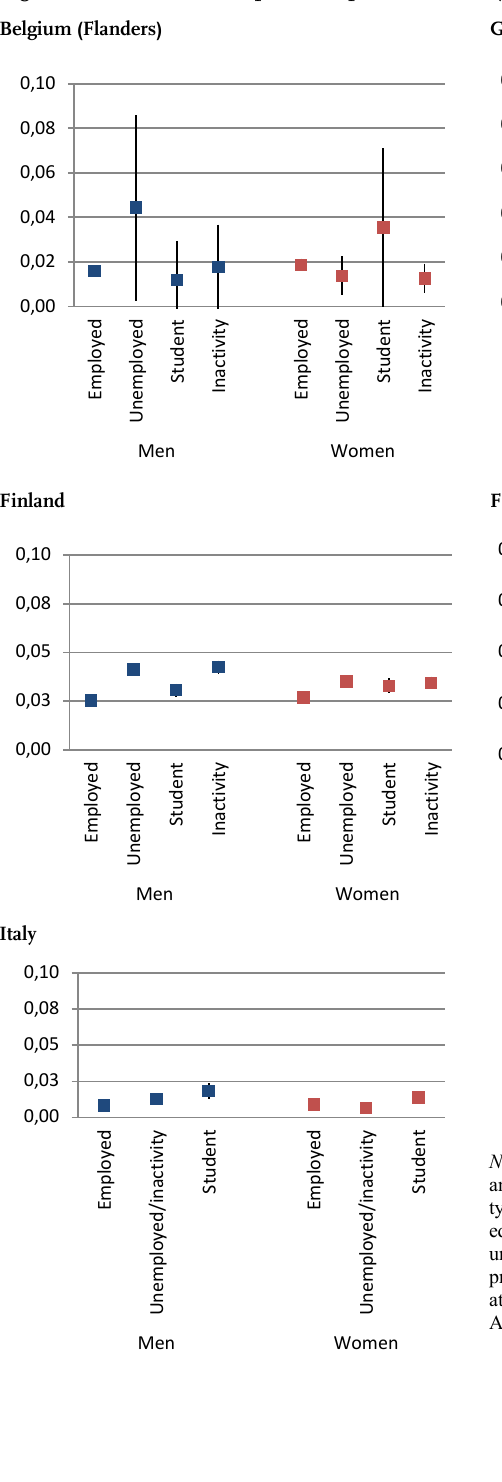
Figure 5 : Predicted separation probabilities by employment status and